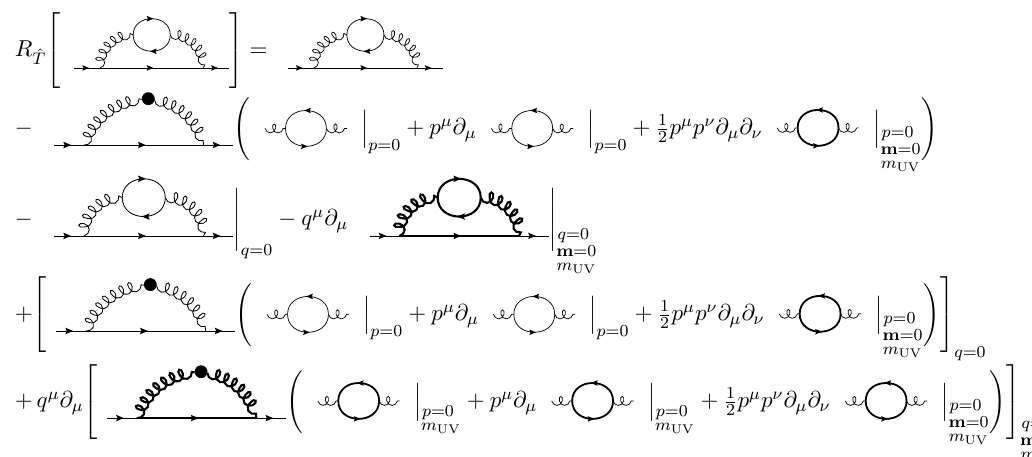
Figure 9. Merging of the soft and UV forest for a gluonic self-energy correction nested in a fermionic self-energy correction. The action of ˆ T is unfolded explicitly. The four-momentum p (resp. q ) corresponds to the external momentum of the inner (resp. outter) self-energy